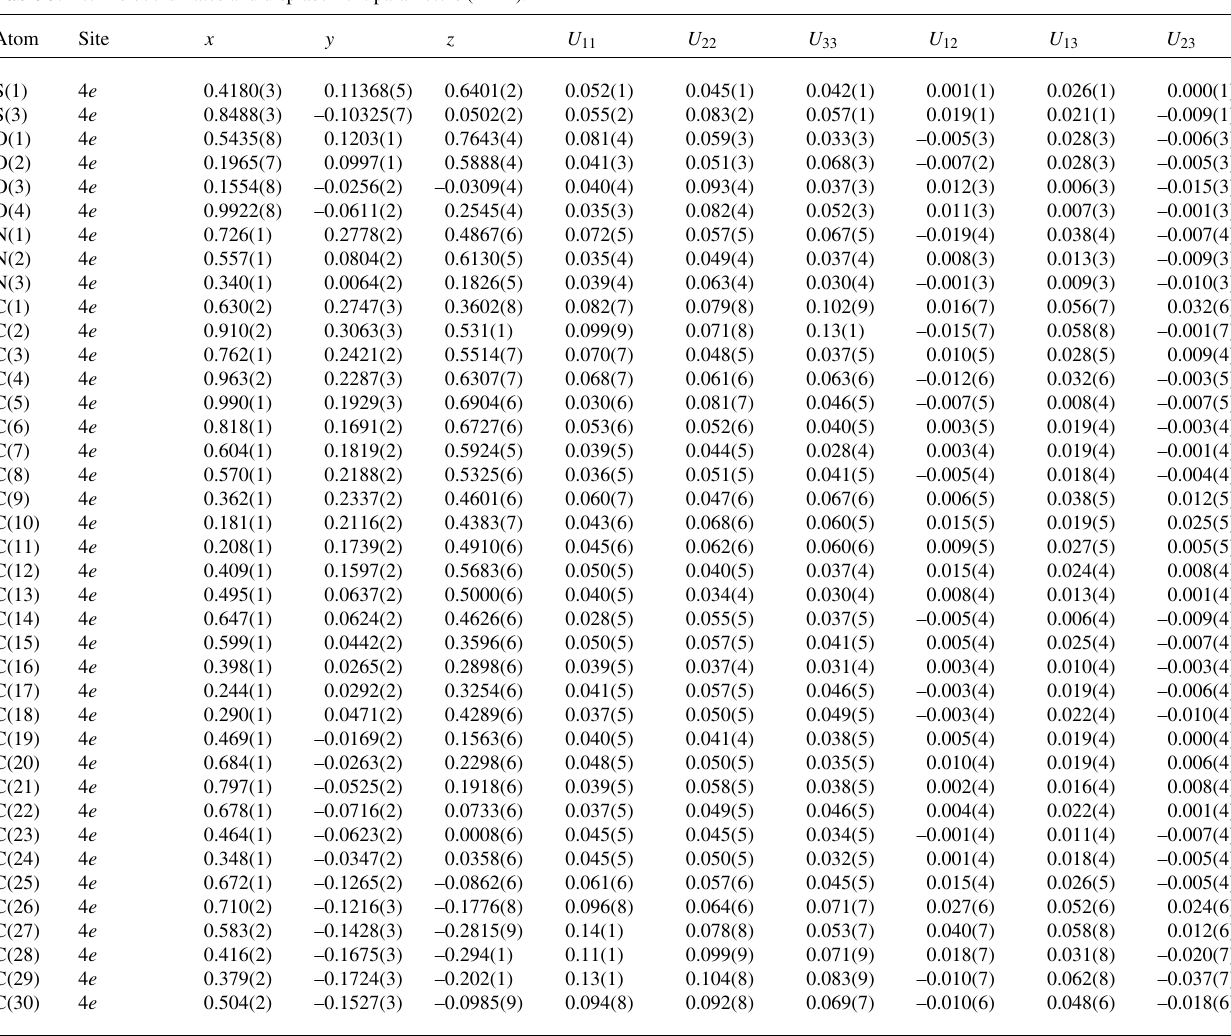
Table 3. Atomic coordinates and displacement parameters (in Å 2 )